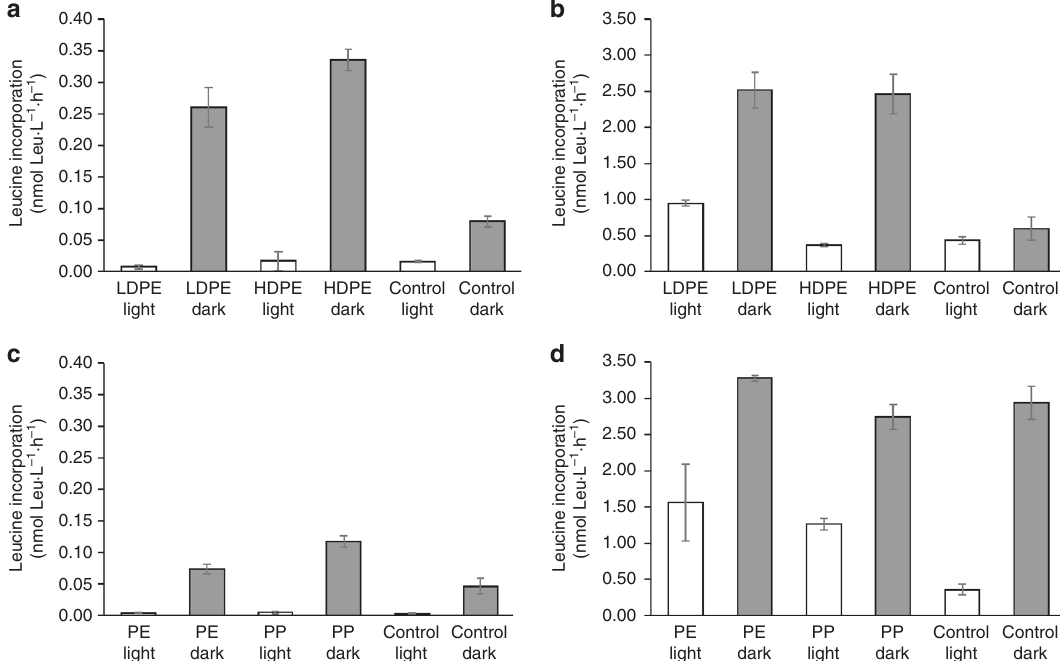
Fig. 3 Leucine incorporation in the 30-days plastic leaching experiments. Leucine incorporation (nmol Leu L − 1 h − 1 ) for: LDPE and HDPE treatments after a 24 h and b 48 h of incubation; PE and PP packaging plastic after c 24 h and d 48 h of incubation. Error bars represent the standard deviation of the mean of the triplicate cultures. HDPE high-density polyethylene LDPE low-density polyethylene, PE polyethylene, PP polypropylene